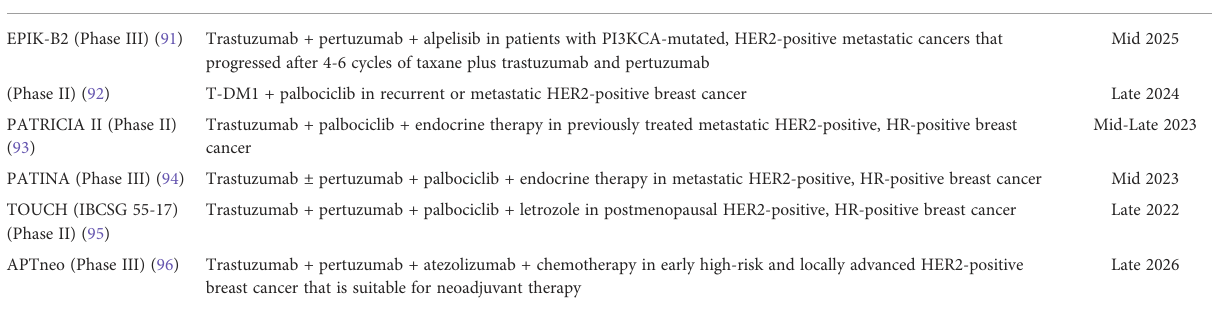
TABLE 3 Selected ongoing clinical trials on combination therapies. Clinical Trial